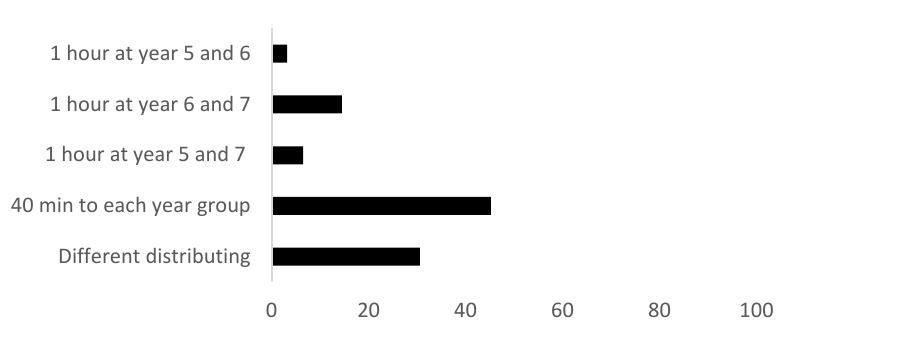
Figure 2. An overview of how the schools distributed the allocated 76 h of obligatory PA time in years 5–7. The columns in the figure show distribution between schools (%) in relation to the various alternatives for organizing allocated hours ( n = 69) Data from 2014.